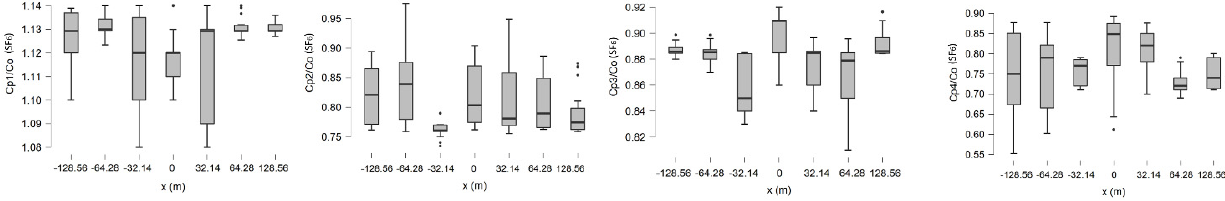
Figure 2. Cp/Co for SF 6 using CALRANS99 (Data 1) for unstable atmospheric conditions concerning the downwind distances. The Idaho Falls Tracer experiment was conducted to measure SF6 in 2008 at Idaho Falls, a city in Idaho. As part of this study, two simultaneous experiments were conducted, one had a barrier downwind of the line source to represent a roadside sound wall, the other had no barrier. In this analysis, we only use the data from the no-barrier experiment to test the model concentrations for a flat roadway case. The line source in the experiment was 54 m long, the field results have been processed to represent what would have been measured had the source been infinitely long. Therefore, the input source is very long (1 km) and only one receptor is only modeled at each perpendicular downwind distance. The source is modeled with a unit emission rate because the measured emission rates are slightly different for each day. The emission rates for day 1, 2, 3, and 5 are 0.05 g/s, 0.04 g/s, 0.03 g/s, and 0.03 g/s respectively. The surface meteorology file contains only the 15 min periods where the wind direction was within 25 degrees of perpendicular to the line source. Additionally, day 4 is omitted completely, because the winds were rather erratic, and the receptor grid was not always downwind of the line source. The SF6 is measured in this field experiment for 18 m, 36 m, 48 m, 66 m, 90 m, 120 m, and 180 m downwind distances [24]. The Raleigh 2006 experiment was conducted to measure NO in Raleigh, North Car- olina. The line sources were run with unit emission rates so they can be multiplied by the traffic and emission factor to determine the modeled concentration. The line source was 1 km long, and 8 lanes were used (4 lanes on each side of the median). The emission factor used was 0.5 g/vehicle/km from Venkatram 2007. The data are available for every 10 min of air [25,26].